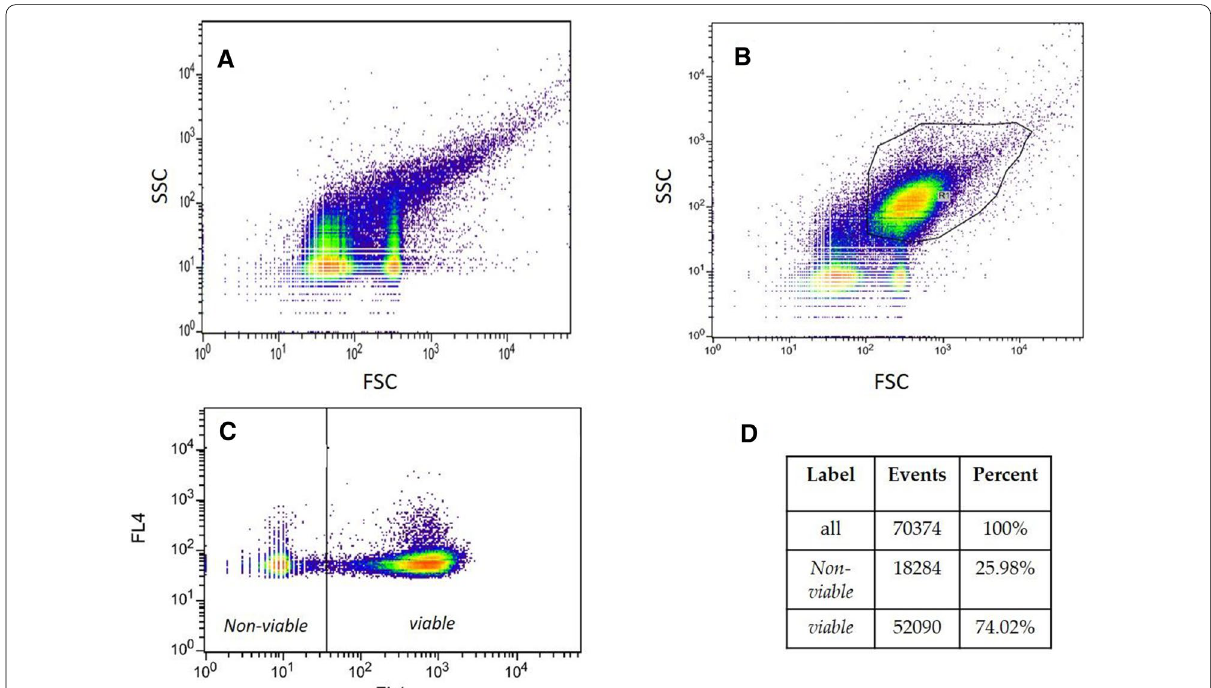
Fig. 1 Gate definition for viability evaluation of Sulfolobus acidocaldarius . A density plot of side scatter versus forward scatter for ConA-rhodamine in PBS buffer, showing the background, color code: red-high to purple-low; B density plot of side scatter versus forward scatter for cells stained with FDA and ConA-rhodamine, showing the cell gate; C density plot of FL1 (536/40 nm bandpass) versus FL4 (610/30 nm bandpass) of cells gated in B ; D statistics of FL1 vs. FL4 shown in